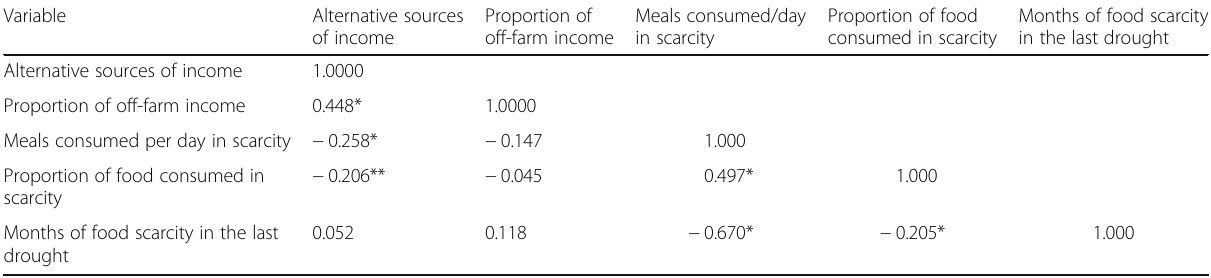
Proportion of Meals consumed/day Proportion of food Months of food scarcity of income off-farm income in scarcity consumed in scarcity in the last drought